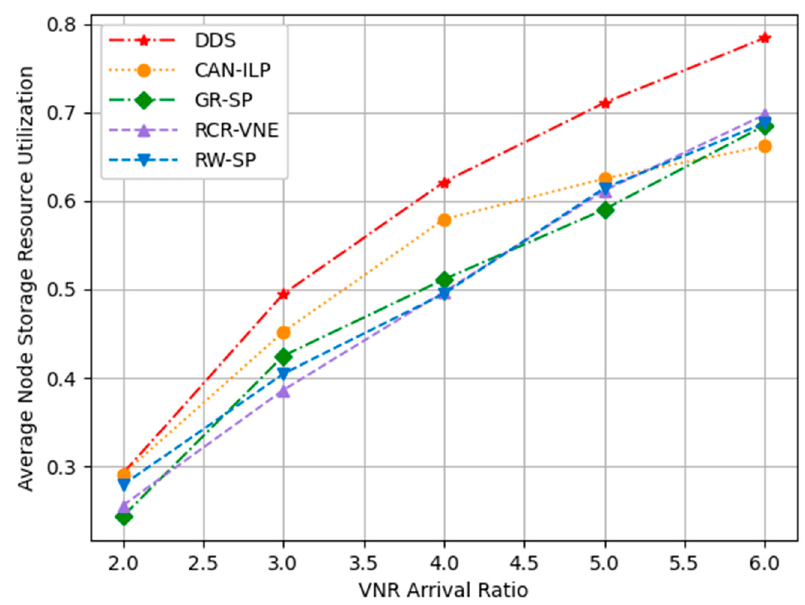
Figure 8. Average node storage resource utilization under various VNR arrival ratios.